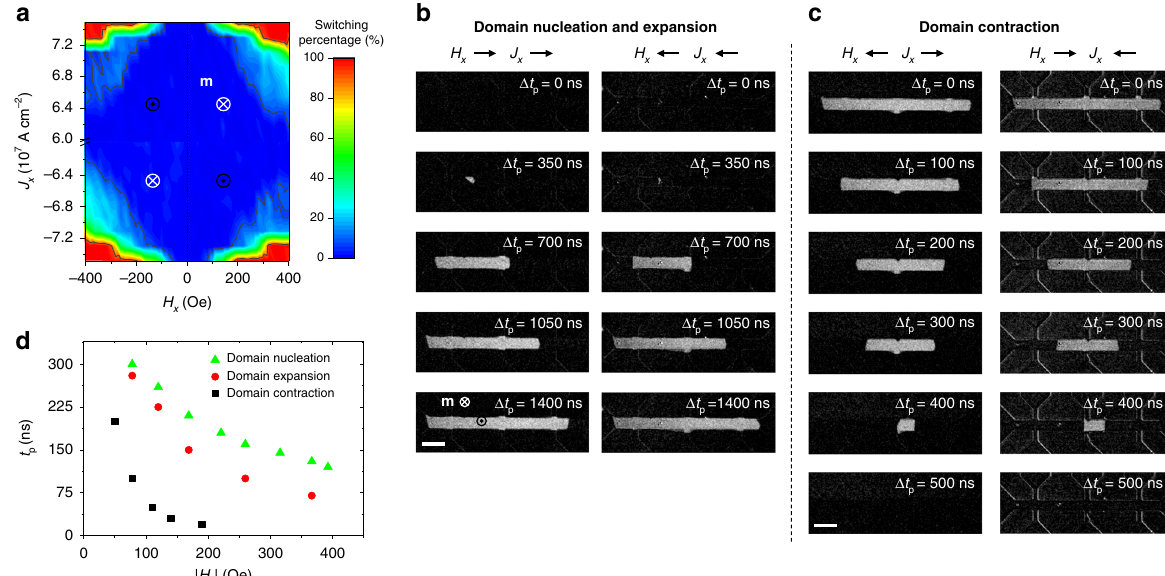
Fig. 3 Current-induced DW dynamics in embedded TmIG racetracks. a Magnetization switching diagram showing the percent change of the magnetization underneath the Pt current line as a function of J x and H x . For each switching event, the initial m was always set fully up or down by applying an out-of-plane fi eld H = + 100 or − 100 Oe, respectively ( + m for ± H (cid:3) J – m for ± H J z x , z , ± z according to the symmetry of SOT switching). Forward switching is x and triggered by a single current pulse with t p = 500 ns. b Sequence of differential MOKE images showing current-induced domain nucleation and expansion and c domain contraction for the different combinations of H x and J x that allow each scenario to take place. Δ t p = Nt p is the accumulated pulse time after applying N current pulses of length t p . The pulse length is t p = 350 and 50 ns, and the current density | J x | = 0.65× 10 8 and 0.75 × 10 8 A cm − 2 for b and c , respectively. | H x | = 250 Oe in all cases. Bright and dark MOKE contrasts correspond to + m and – m states, respectively. It is noteworthy that the TmIG fi lm not covered by Pt remains fully down magnetized. Scale bars, 20 μ m b , c . d Switching diagram showing the minimum pulse length t p required to nucleate a domain starting from a fully saturated fi lm (green triangles), to expand a domain (red circles), and to contract a domain (black squares) as a function of | H x |. The current density of the pulses is fi xed to | J x | = 0.75 × 10 8 A cm − 2 . The results show that it is easier to move a DW than to nucleate a domain, and that the onset of DW motion is lower for contraction relative to gyromagnetic ratio, α the damping constant, e the electron charge, θ ħ the reduced Planck constant, μ 0 the vacuum permeability, SH the effective spin Hall angle of Pt, and H DMI the effective DMI fi eld 12,16 . Taking γ ~ 1.43 × 10 7 Oe − 1 s − 1 (ref. 41 ) and Δ DW ~ 20 nm (Fig. 2), and by approximating H x + H DMI ≈ H x = 300 Oe,